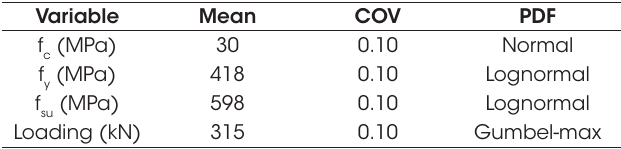
Random variables for 2D RC frame